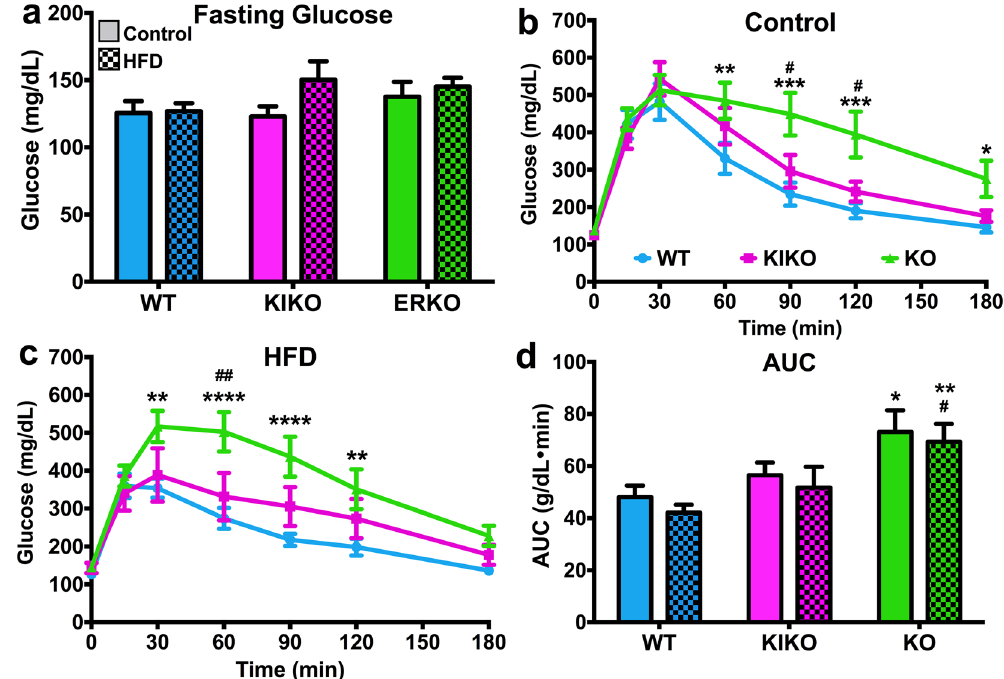
Figure 3. Fasting glucose levels and glucose tolerance test (GTT) in adult females from all genotypes after 20 weeks of adult chow diet. ( a ) Fasting glucose levels. Results from the GTT from ( b ) all genotypes from Control- fed dams and ( c ) all genotypes from HFD-fed dams. ( d ) Area under the curve (AUC) analysis for all genotypes from both maternal diets. ( a and d ) Data were analyzed by a two-way ANOVA with post-hoc Newman-Keuls test. ( b and c ) Data were analyzed by repeated-measures, multi-factorial ANOVA with post-hoc Newman- Keuls test. See Fig. 1 for information on treatment categories, sample sizes, and statistical comparisons ( a/ * /# = P < 0.05; b/ ** /## = P < 0.01; c/ *** /### = P < 0.001; d/ **** /#### = P <